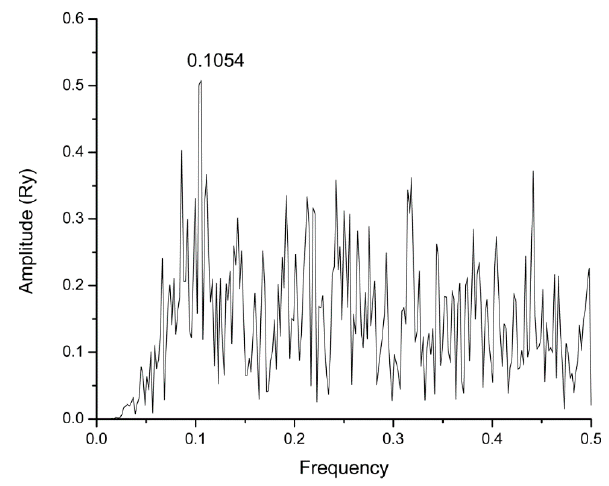
Figure 3. Cross-spectrum (CS) of M pro and Ebselen. Table 1. Docking scores of the compounds binding to the catalytic site.